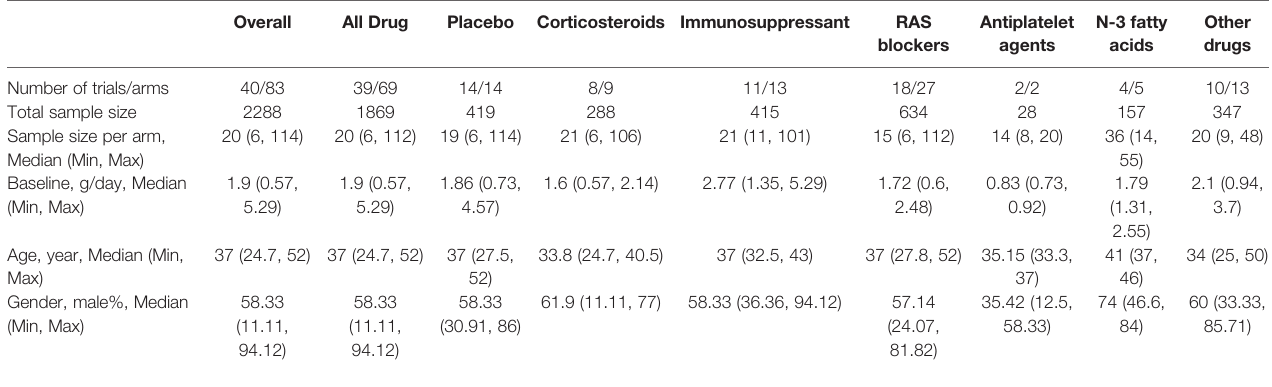
TABLE 1 | Characteristics of the included literature. Overall All Drug Placebo Corticosteroids Immunosuppressant RAS